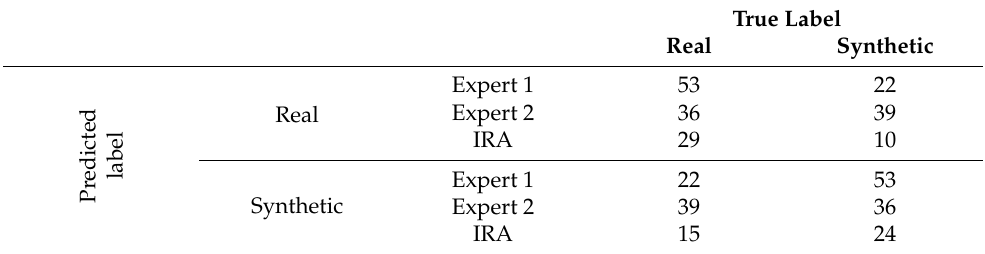
Table 2. Confusion matrix of visual Turing test. IRA: inter-reader agreement.